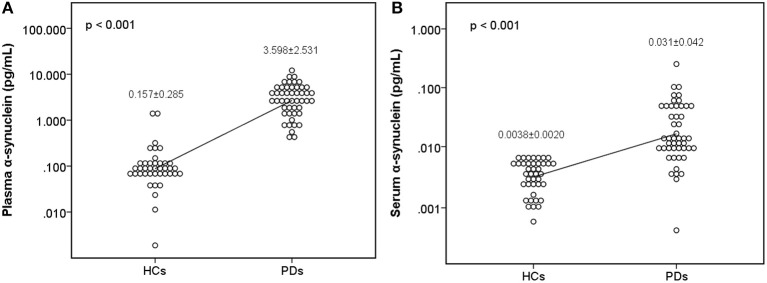
Scatter diagram of plasma α-synuclein levels and serum α-synuclein levels on a logarithmic scale between the healthy control group and the Parkinson's disease group. Significant differences in α-synuclein levels were detected between the two groups in both plasma samples (A) and serum samples (B). PD, Parkinson's disease.